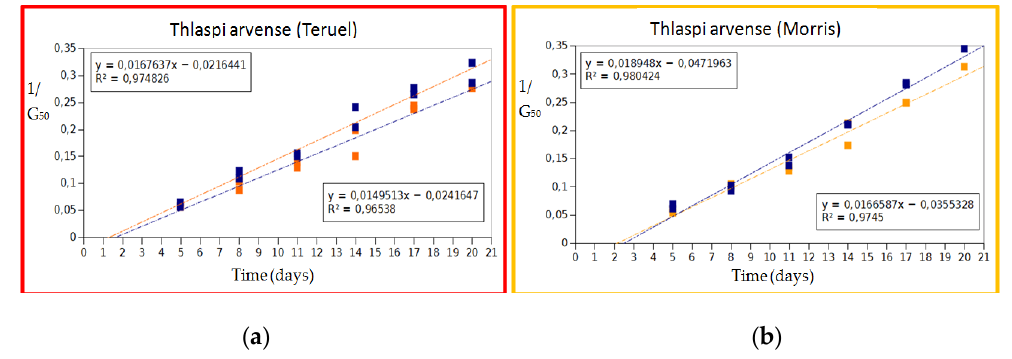
Figure 1. Inverse of the time (in days) for 50% of germination (G50) of the Teruel ( a ) and Morris ( b ) seeds. Orange quadrats, basal seeds; blue quadrats, apical seeds. The regression line for each type of seed is also provided, as well as the intersection that would correspond to the base temperature (T b ) for each one.